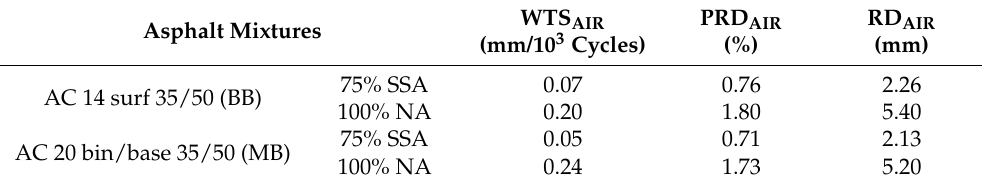
Figure 8. Evolution of the rut depth of the different asphalt mixtures in the WTT test. The results obtained demonstrate that the mixtures with SSA are much less suscep- tible to deformation than the equivalent conventional mixtures. Both asphalt mixtures with SSA have wheel tracking slopes (WTS AIR ) lower than 0.1 mm/10 3 cycles, less than half of the identical asphalt mixtures with NA. The irregular and rough shape of the SSA may have contributed to this excellent performance at higher temperatures. Figure 9 shows images of the rut depth obtained in the AC 14 mixtures to exemplify the differences be- tween the studied asphalt mixtures (100% natural aggregates and 75% SSA).